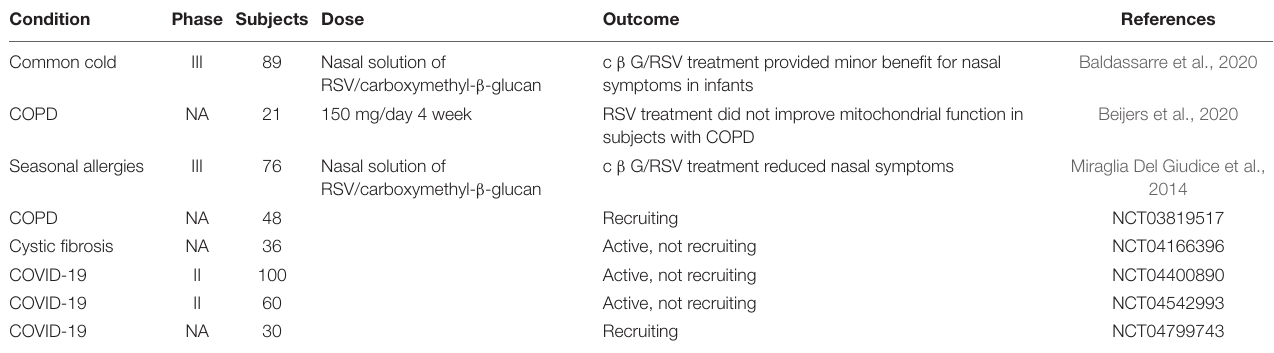
TABLE 9 | Clinical trials of resveratrol for respiratory conditions.